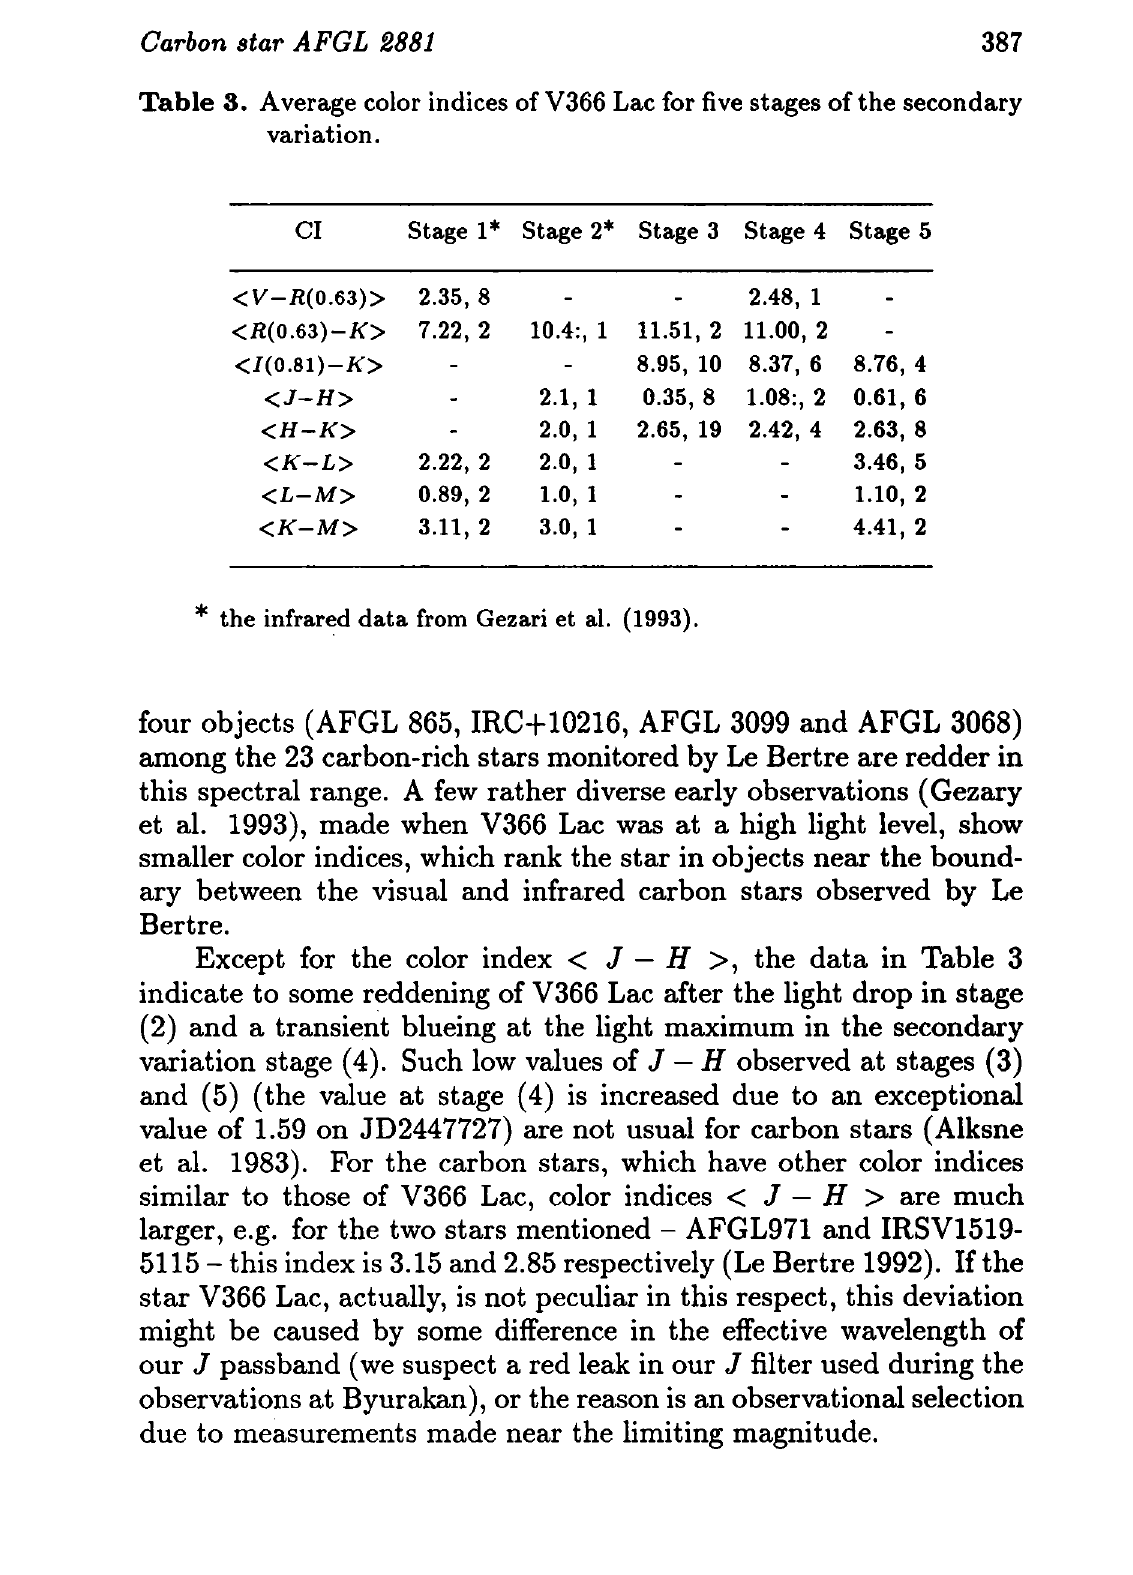
Table 3. Average color indices of V366 Lac for five stages of the secondary